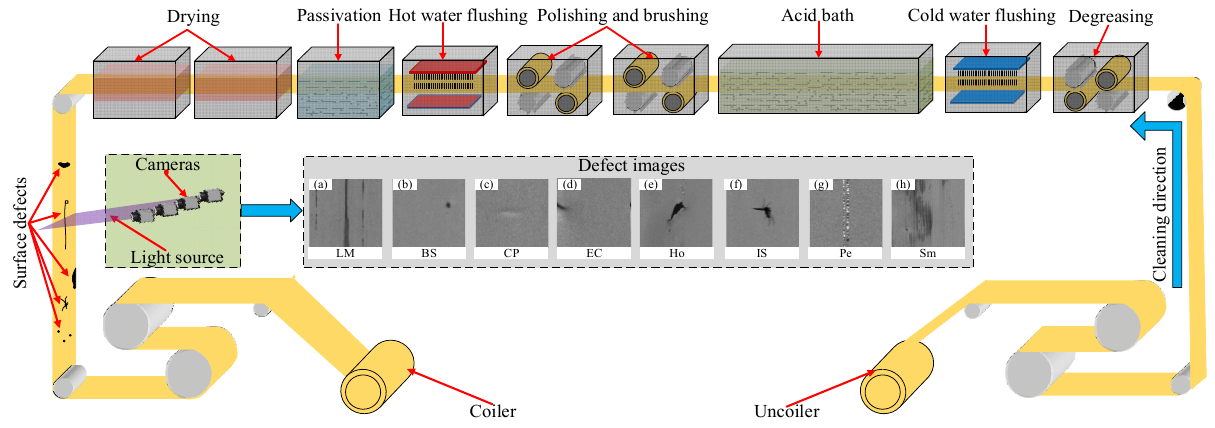
Figure 1. Image acquisition process of surface defects of copper strip: (a) LM, (b) BS, (c) CP, (d) EC, (e) Ho, (f) IS, (g) Pe, and (h) Sm. Table 1. Characteristics of surface defects.